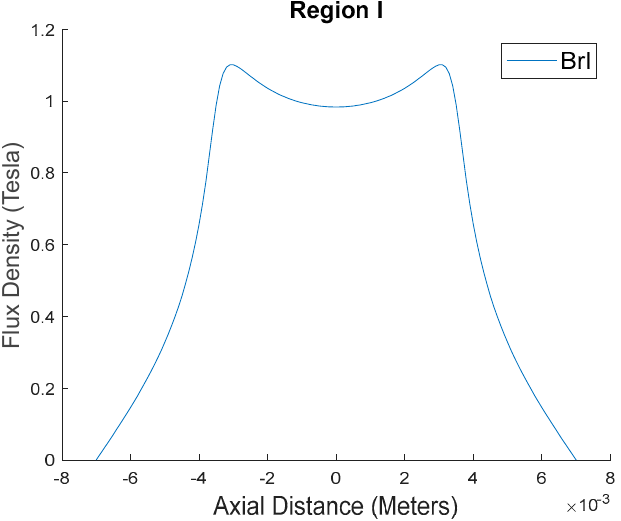
Figure 14. Radial flux density as a function of axial distance—Calculated using (18b).